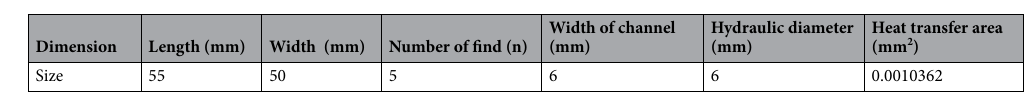
Table 3. Properties of microchannel heat sink dimensions.